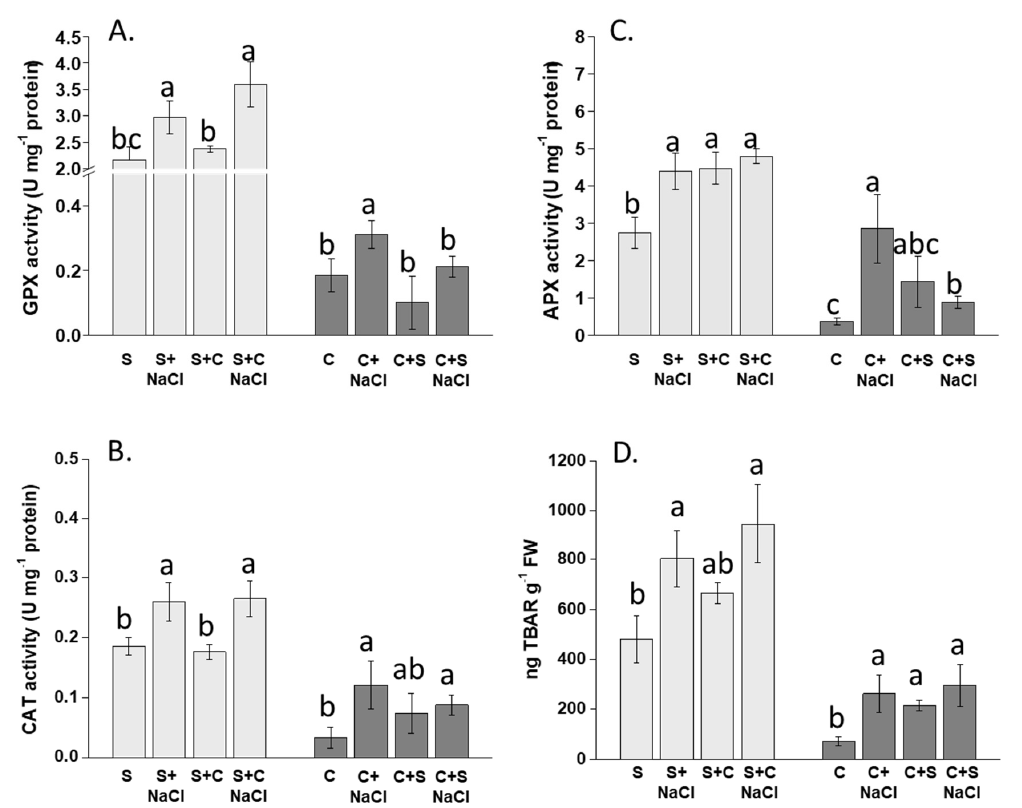
Figure 8. ( A ) Guaiacol peroxidase (GPX) activity in leaves of soybean and C. album , treated and nontreated with NaCl. ( B ) Catalase (CAT) activity in leaves of soybean and C. album , treated and nontreated with NaCl. ( C ) Ascorbate peroxidase (APX) activity in leaves of soybean and C. album , treated and nontreated with NaCl. ( D ) Lipid peroxidation, expressed as thiobarbituric acid reactive substances (TBARS) in leaves of soybean and C. album , treated and nontreated with NaCl. Different letters within each group of bars indicate significant differences at p < 0.05, n = 3. S = soybean; C = C. album . The experiment was replicated twice, and only data from one representative experiment are shown.